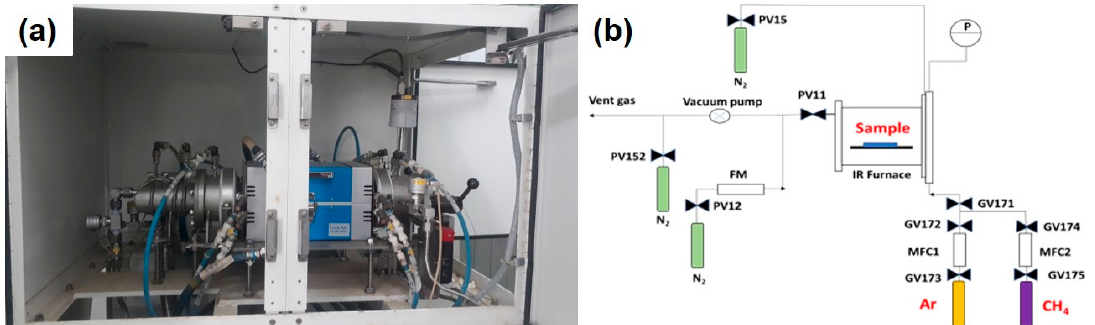
Figure 1. Experimental CVD set-up: ( a ) digital photo; ( b ) schematic diagram. For catalyst pretreatment, the furnace was heated in an argon flow of 1000 sccm to the given pretreatment temperature (e.g., 750 °C, 850 °C, and 950 °C) and was maintained at a gas to room temperature. The catalyst was taken out and used for analysis.